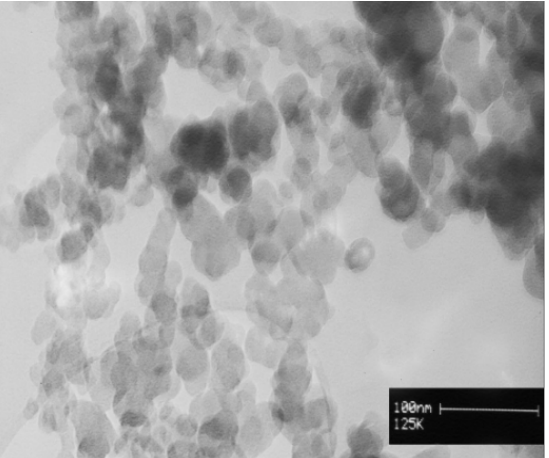
Figure 2. The nano-silica powder.